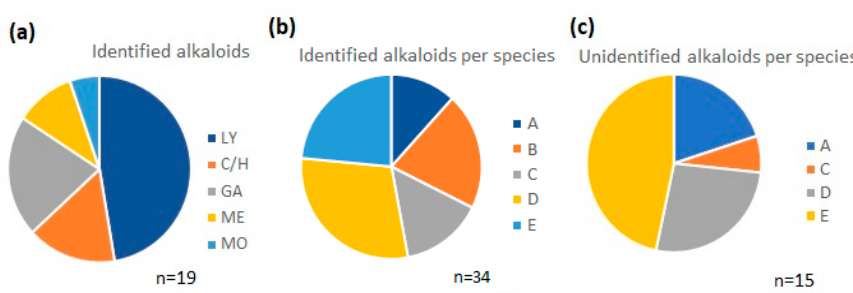
Figure 3. Graphical representation of the chemical profile of Phaedranassa Herb. species by GC-MS. ( a ) Distribution of alkaloids identified in all samples by type; ( b ) comparison of number of identified alkaloids among species; ( c ) comparison of number of unidentified alkaloids among